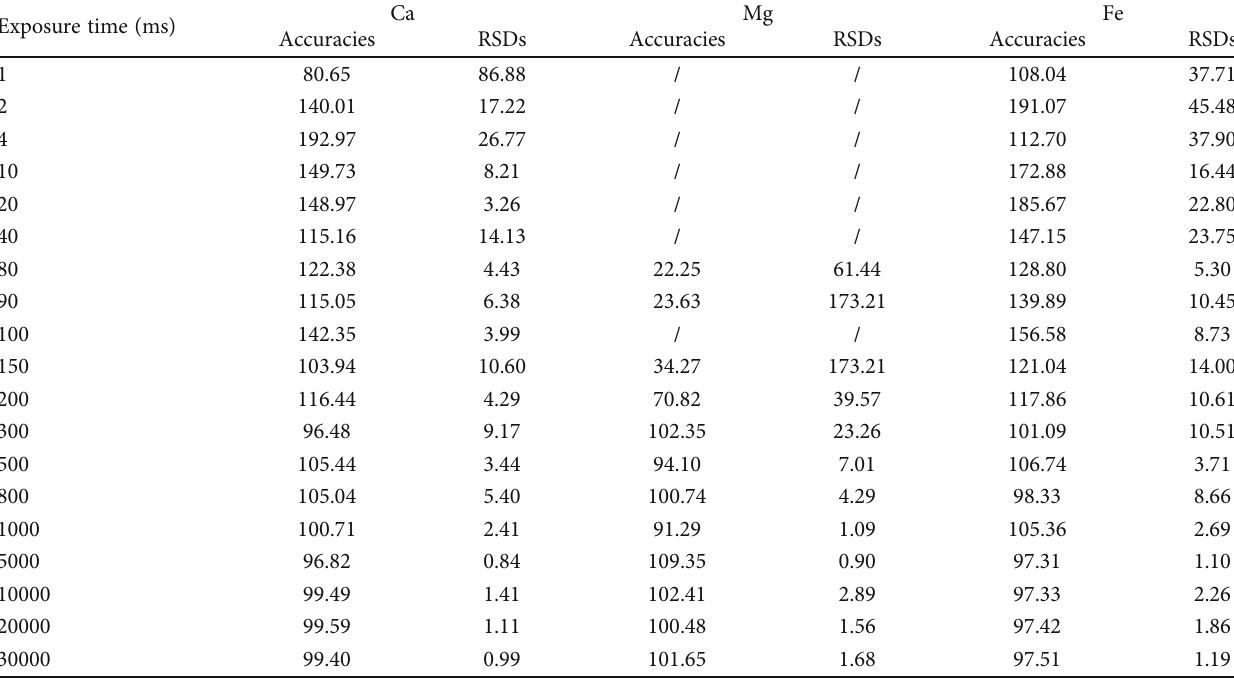
Table 2: Accuracies and relative standard deviations (RSDs) of the measurements of Ca, Mg, and Fe at di ff erent exposure times. Data shaded are averaged and presumed as the true values of Ca, Mg, and Fe contents. The RSD data were the same as those in Figure 6. Slashes of Mg mean no signal was detected with the set exposure